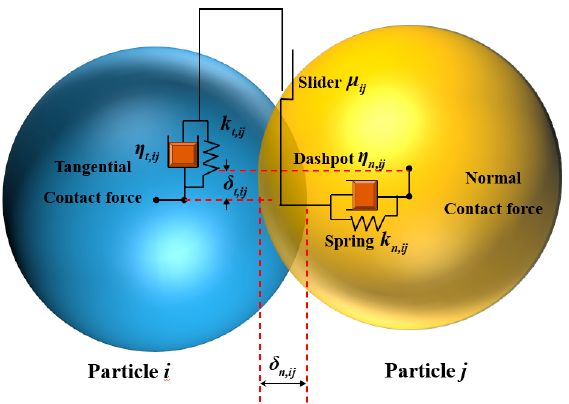
Figure 1. Schematic diagram of the soft sphere collision model.